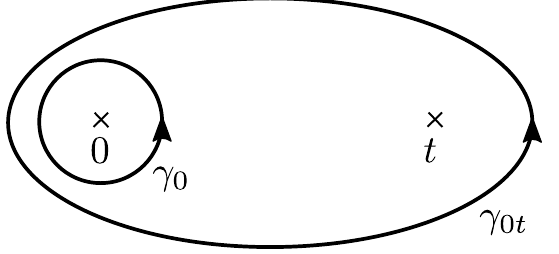
Figure 2 . An elementary path (cid:13) 0 has monodromy (cid:18) 0 and a composite path (cid:13) 0 t enclosing two singular points has composite monodromy (cid:27) 0 t